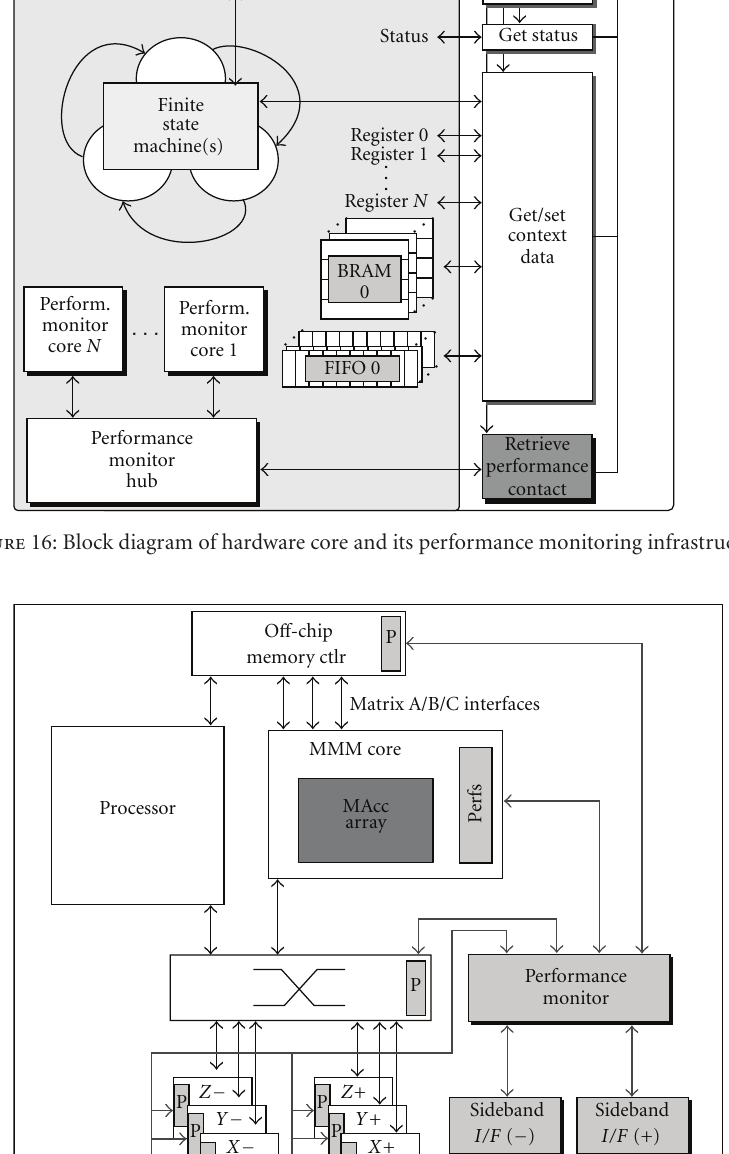
when transferring large datasets between nodes, the higher bandwidth AIREN implementation will outperform Fast Ethernet. However, for a designer to realize the need to sacrifice single node performance to include the necessary on-chip infrastructure for the network might not be so easily